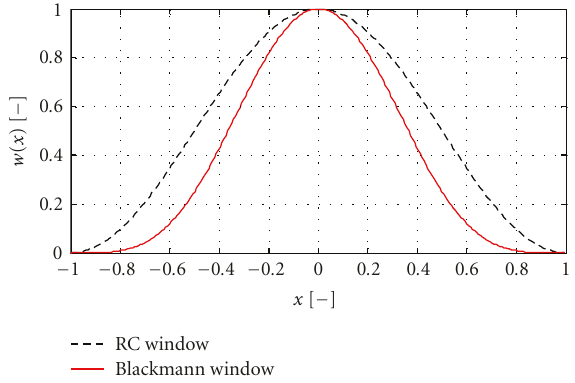
Figure 4: Raised cosine window versus general Blackmann window ( a 0 = 3 / 8; a 1 = 4 / 8; a 2 = 1 /